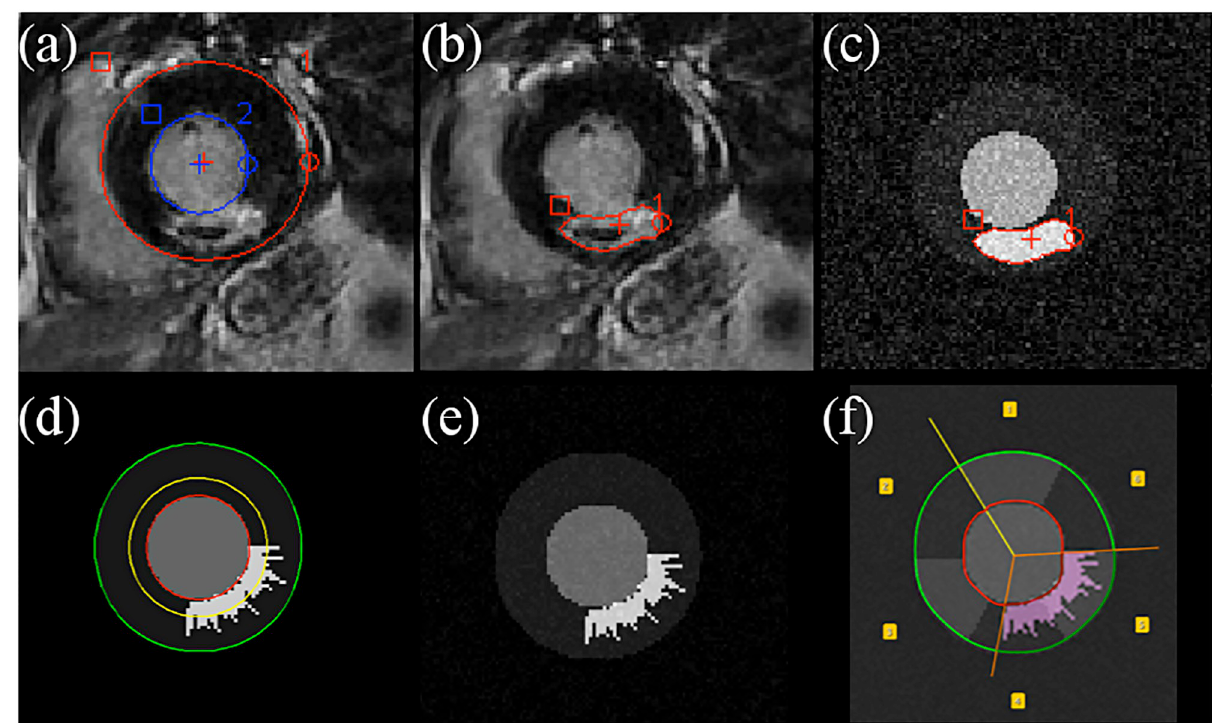
Fig 5. Example of numerical phantom generation (c), (d), (e) and (f) from a real clinical data set (a) and (b). Images were acquired with a 3D-IR-GRE sequence on a patient with a myocardial infarct. (a) Traced endocardial and epicardial contours on one slice (2D), (b) manual lesion segmentation, (c) output synthetic image (2D). The figures (d), (e) and (f) illustrate transmural extent and ESL calculation on a numerically generated infarct with known size and variable transmural extent around a user-defined mean value. (d) Red, green and yellow contours are respectively the endocardial and epicardial borders, and the mean simulated transmural extent; (e) final synthetic image. (f) CMRSegTools segmentation output (HMRF-EM); magenta pixels on the synthetic image correspond to those classified as myocardial infarct on the numerical phantom. The orange wipers delineate the ESL.